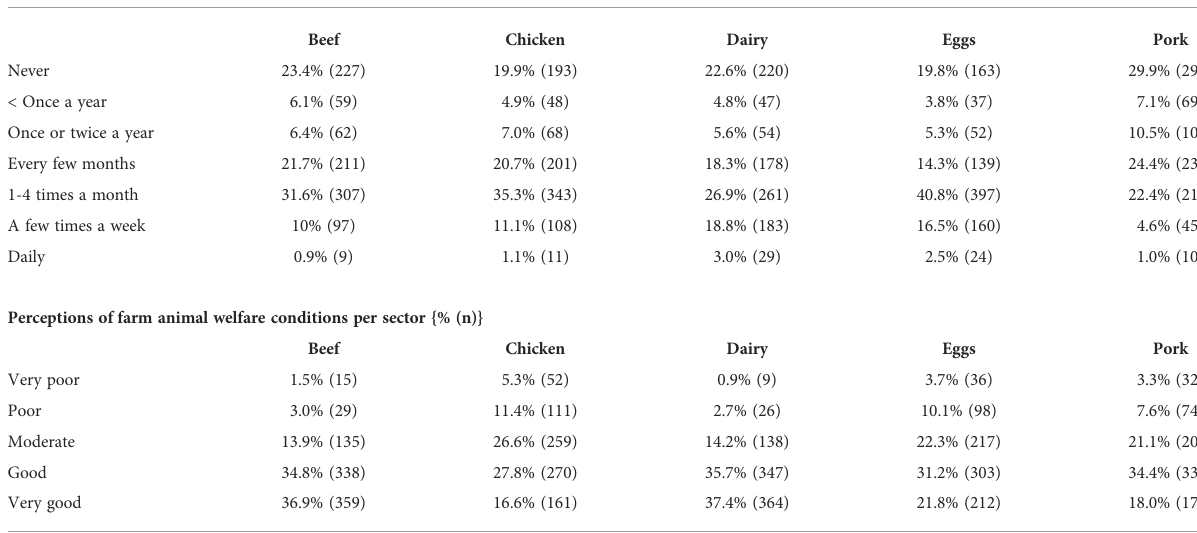
TABLE 2 Frequency of consumption of animal welfare versions of products and welfare rating of animal welfare ratings of associated sectors. Purchase frequency per product type {%